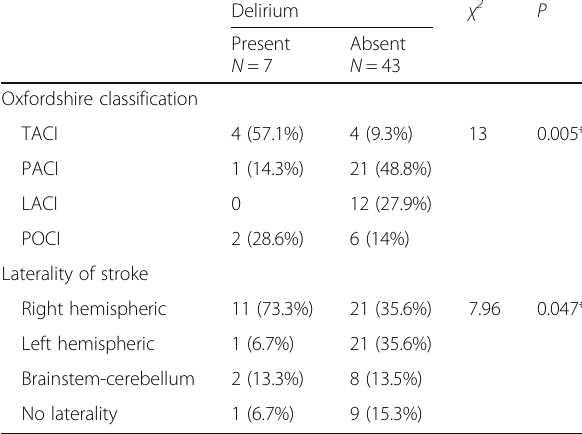
Table 5 Relationship between incidence of delirium and radiological finding in studied stroke patients